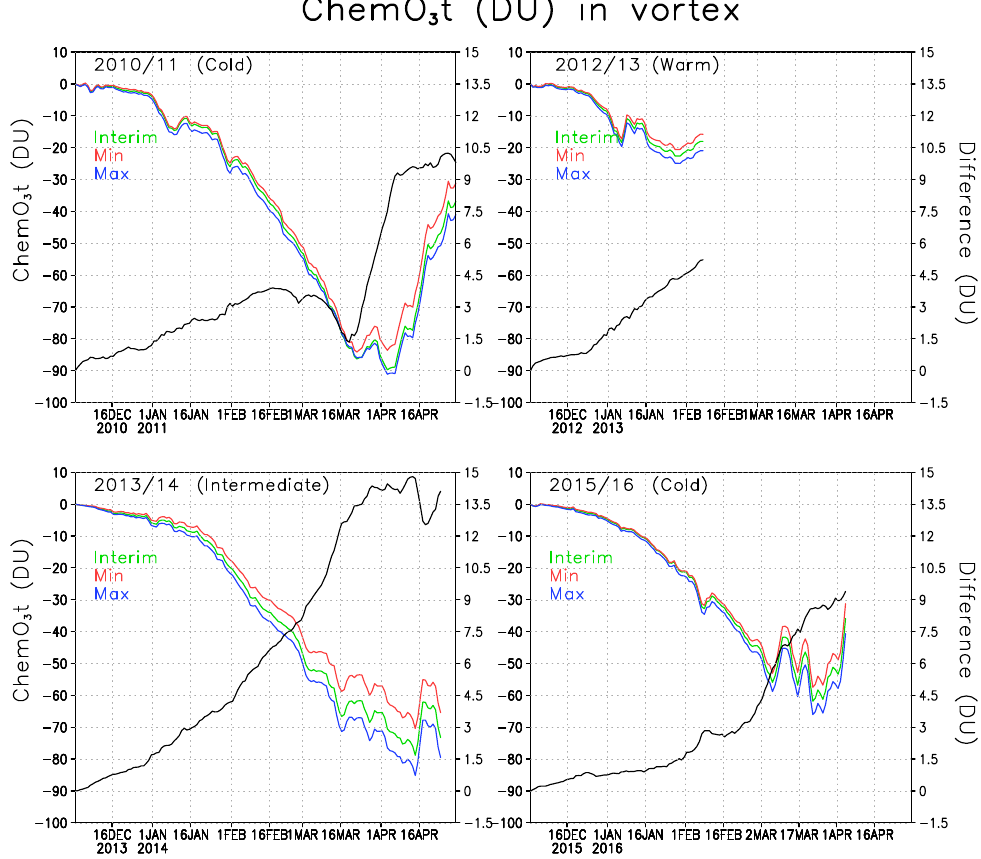
Figure 7. Chemical total ozone loss (DU) and difference between ozone loss in the Min and Max simulations within the Arctic polar vortex. The green line denotes the Interim simulation, blue denotes the Max simulation and red denotes the Min simulation. The difference is in